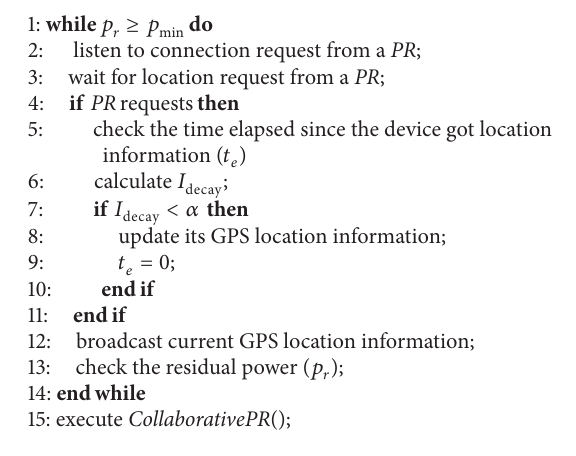
Algorithm 2: ECOPS: CollaborativePB ().